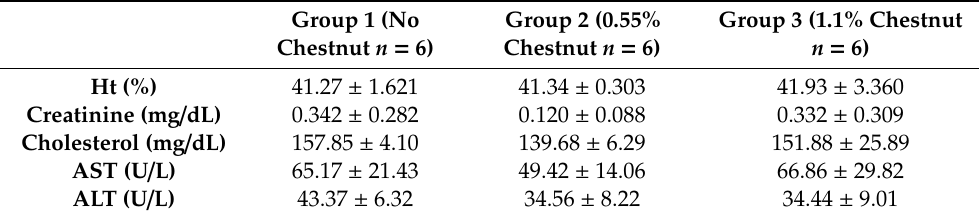
Table 4. Microhematocrit (Ht) and serum biochemical parameters (mean ± standard error).